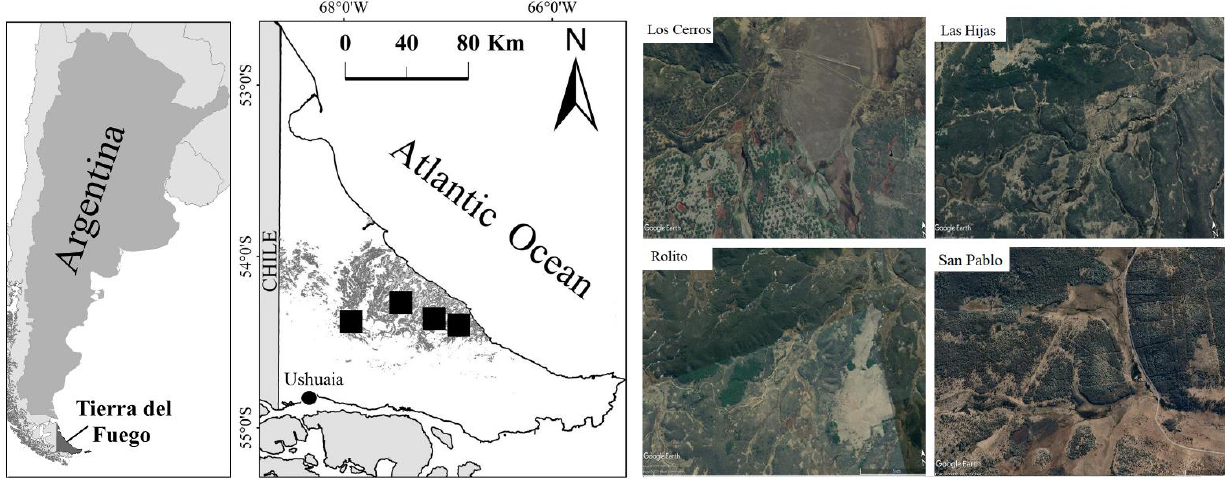
Figure 1. Location of study area (in black squares, from west to east: Los Cerros, Las Hijas, Rolito, and San Pablo ranches) and Nothofagus antarctica forests (grey) in Tierra del Fuego, Argentina. In the right panel, satellite images of the study area at each ranch.